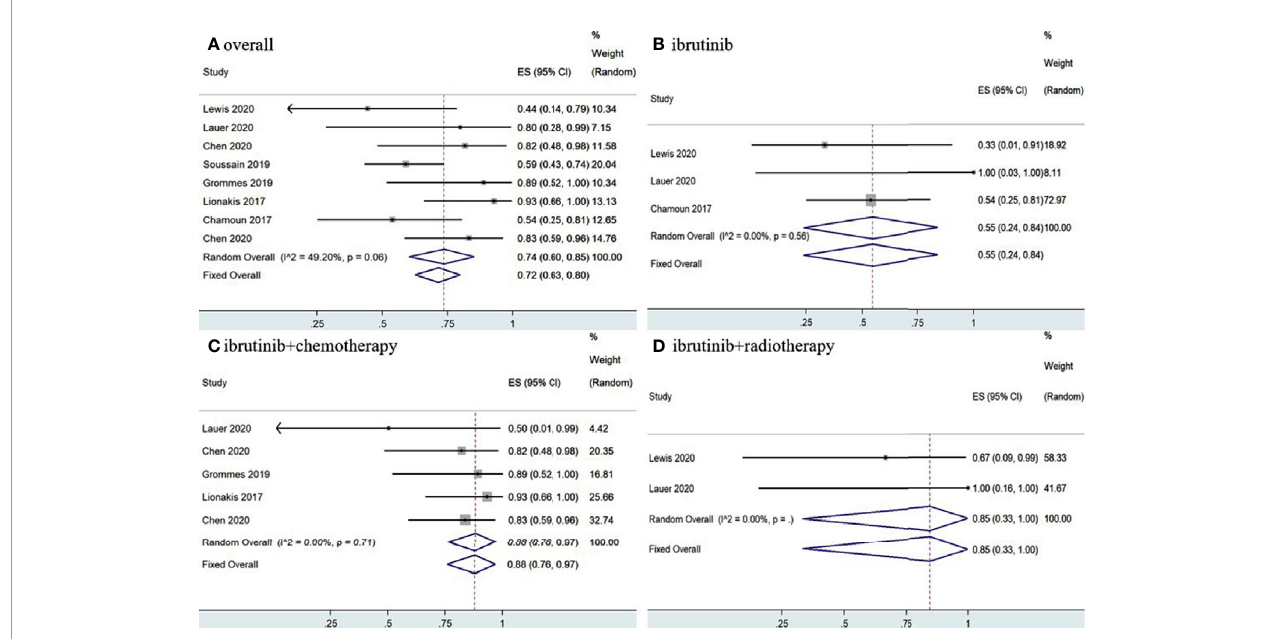
FIGURE 4 | Pooled complete response rates of primary central nervous system lymphoma. (A) Ibrutinib-based regimens. (B) Ibrutinib monotherapy. (C) Ibrutinib combined with chemotherapy. (D) Ibrutinib combined with radiotherapy.